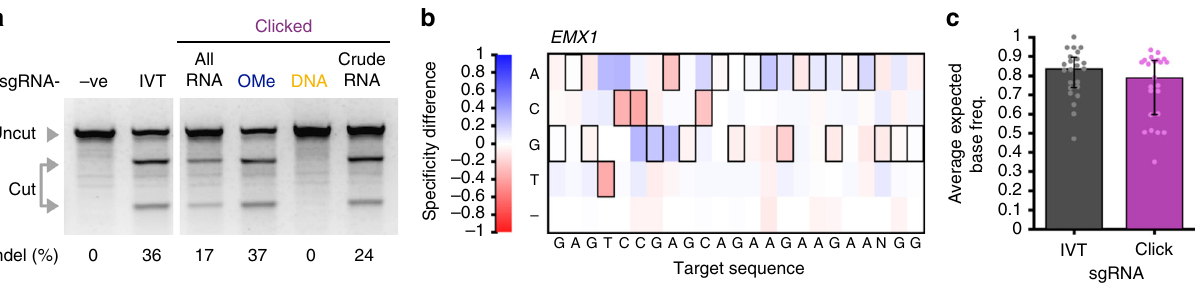
Fig. 4 Clicked ~20 – 79 sgRNA construct activity in cells and their off-target pro fi le. a is a representative gel demonstrating the ability of various sgRNA constructs to mediate indel formation in U2OS cells using the T7E1 assay. Cleavage was quanti fi ed using an Agilent Bioanalyzer (Supplementary Fig. 9, n = 6 for all-RNA clicked and IVT sgRNA and n = 3 for DNA and 2 ′ -OMe modi fi ed clicked sgRNAs, biological replicates). Indels (%) = (1 − (1 − f cut / f total ) 0.5 ) × 100, where f stands for fraction. b illustrates the difference in speci fi city of IVT and clicked sgRNA as determined by CIRCLE-seq. All statistically signi fi cant cleavage sites (off- and on-target; Supplementary Fig. 10) were converted into a heat map of the frequency of each base observed at each position of the target sequence. Values for IVT sgRNA were subtracted from clicked sgRNA with the intensity of red indicating lower speci fi city and blue higher speci fi city of the speci fi c base. Black boxes indicate the desired on-target base and ‘–’ indicates deletion. c is a bar graph showing the median expected base frequency across the DNA target (including PAM). Error bars are the Q1 and Q3 quartiles ( n = 23 positions of the target sequence) and dots are the individual points. Note that the clicked constructs have a 5 ′ -C6-NH 2 modi fi cation. Full sequences for the oligonucleotide codes can be found in Supplementary Data 1. Source Data are provided as a Source Data fi